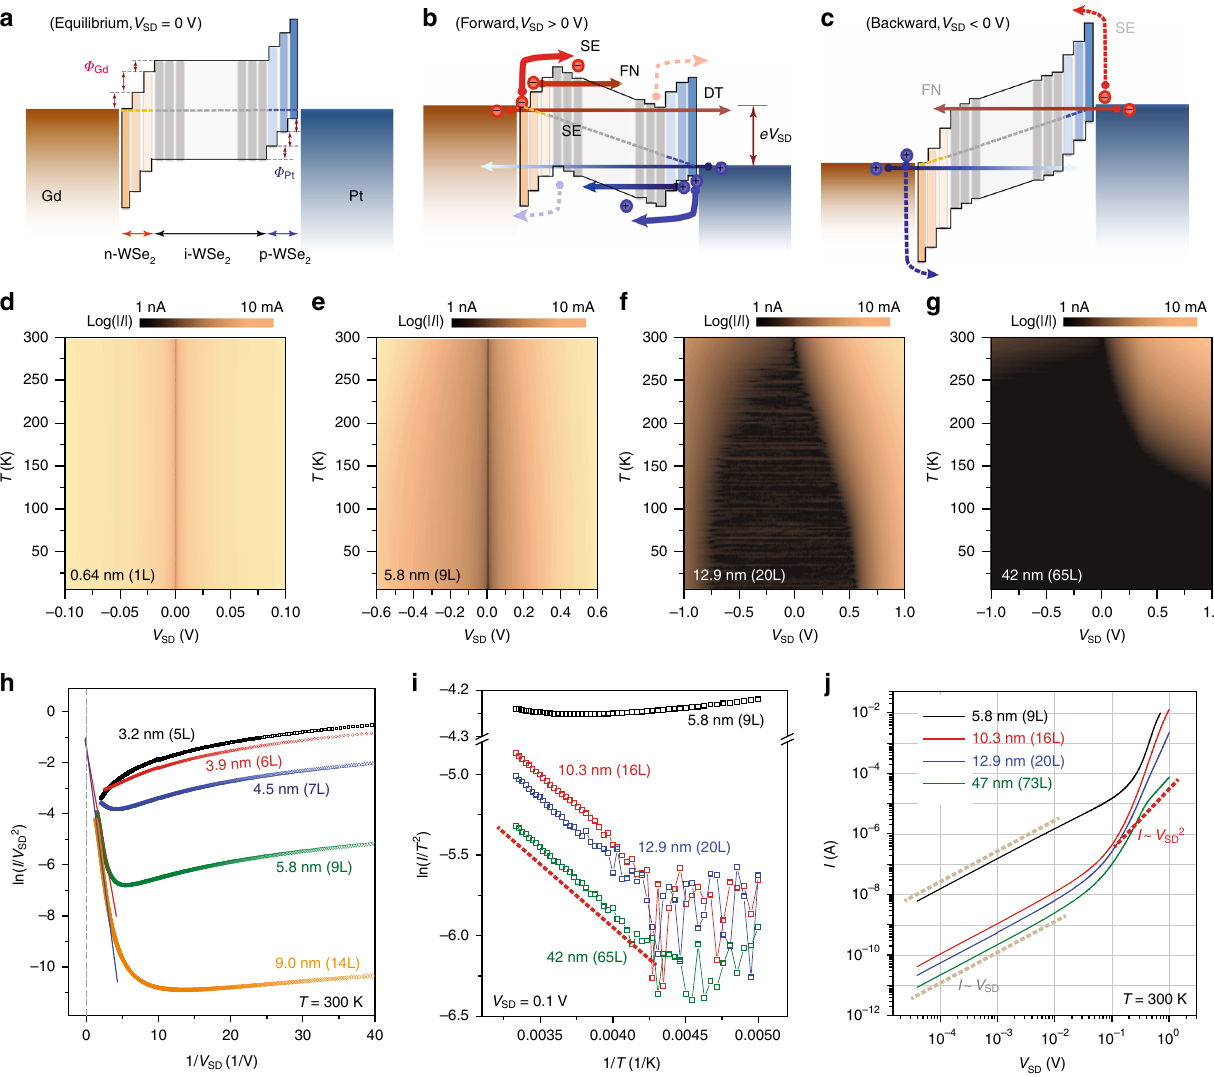
Fig. 3 Charge transport mechanisms through vertical WSe 2 p – i – n heterojunctions. a – c Energy band diagrams of the vertical WSe 2 p – i – n heterojunctions at equilibrium ( a ), forward ( b ), and backward ( c ) V SD . A series of quantum tunneling events through the junctions are denoted with direct tunneling (DT), Fowler – Nordheim tunneling (FN), and Schottky emission tunneling (SE) for both electrons and holes. d – g Two-dimensional display of I vs. V SD curves at varying temperatures from T = 6 to 300K for the devices with WSe 2 fi lms of 0.64nm (1L) ( d ), 5.8nm (9L) ( e ), 12.9nm (20L) ( f ), and 42nm (65L) ( g ). h ln( I / V SD 2 ) vs. 1/ V SD plots, recon fi gured from I – V SD characteristics at T = 300K for different WSe 2 thicknesses. The distinct linear response in the plots of the 5.8-nm-thick (green) and 9.0-nm-thick (orange) fi lms indicates that FN tunneling is the leading quantum transport mechanism through the junctions. No FN tunneling features are observed from the junctions with 3.9nm (6L) and thinner fi lms. i ln( I / T 2 ) vs. 1/ T relations at V SD = 0.1V from the vertical junctions with varying WSe 2 thickness. The thermally activated tunneling events are prevalent in the devices with 10.3nm and thicker fl akes. j I vs. V SD curves for different devices ≈ 47nm) fi lm, current is plotted in log – log scale. At low V SD , current is proportionally increasing to the bias voltage I ~ V SD for all the devices. For a thick ( t WSe 2 proportional to the square of V SD ( I ~ V SD 2 ), a general trait for space-charge-limited transport through low-mobility semiconducting fi